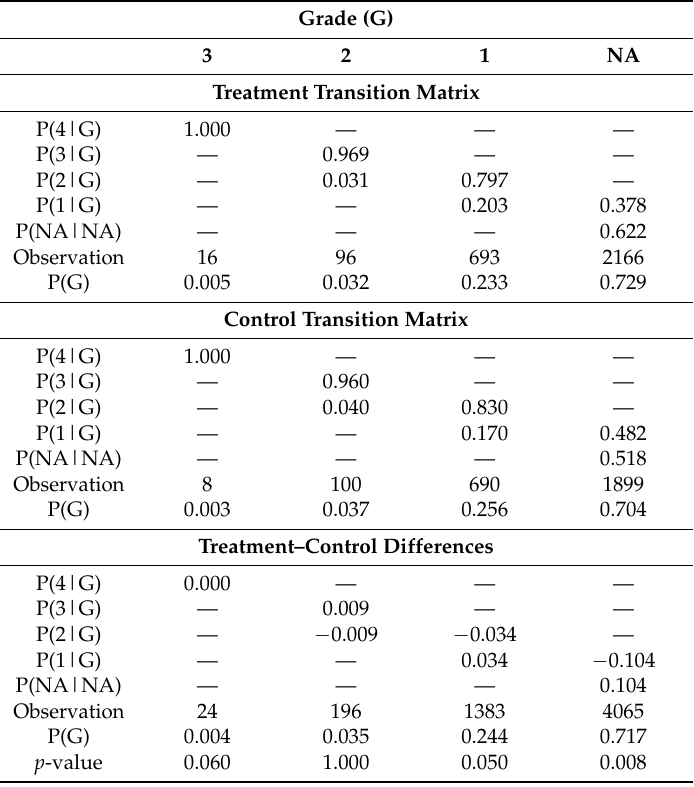
Table 5. Transition matrices (ages